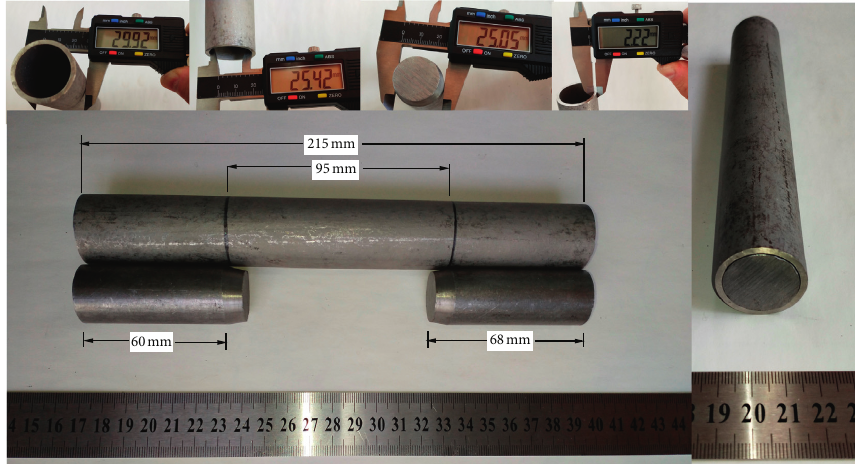
Figure 2: Standard specimen size and structure of a 304 stainless steel thin-wall circular